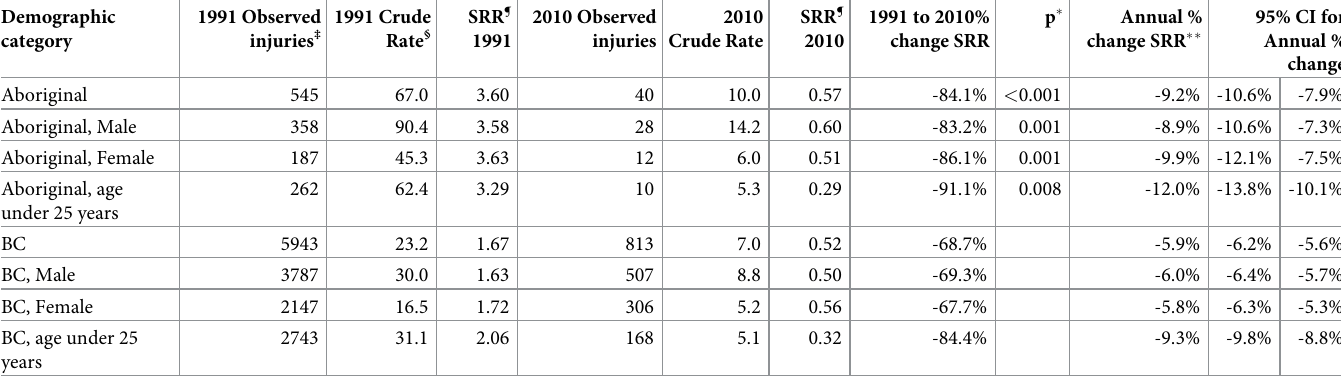
x = average number of persons per room, 2 x = proportion of population, age 25+ years with at least a high school certificate, 3 x = proportion of population, age 25+ years, employed, 4 x = average number of persons per room, 5 x = proportion of population, age 25+ years, employed. 6